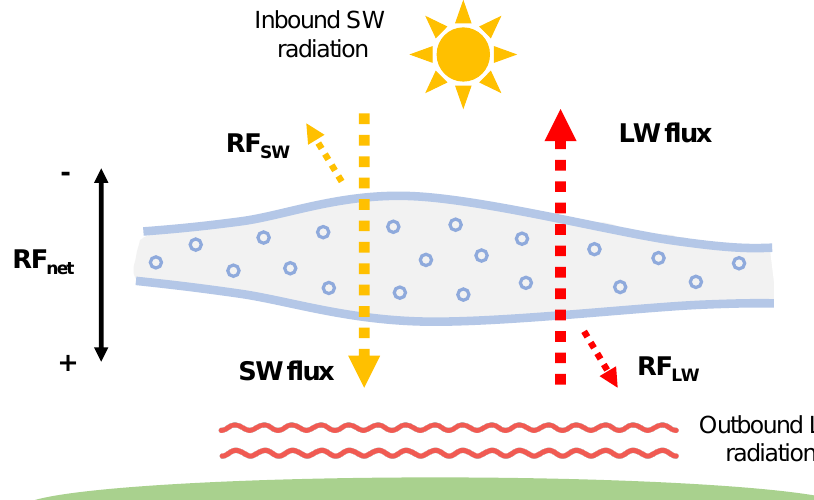
Figure 11. Visual representation of contrail radiative forcing. The net RF constitutes the sum of the LW (terrestrial) and SW (solar) RF